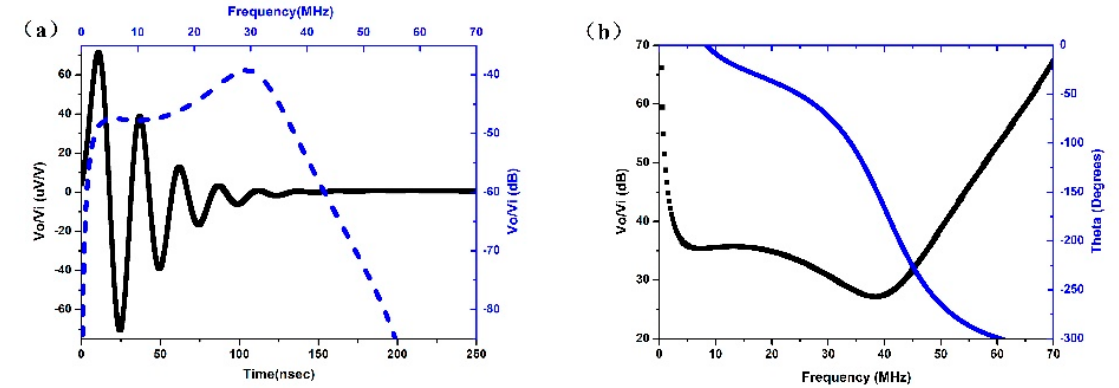
Figure 1. Modeled performances of transducers based on BNT-BT thick film: ( a ) the pulse-echo wave and frequency spectrum; ( b ) the two-way insertion loss.